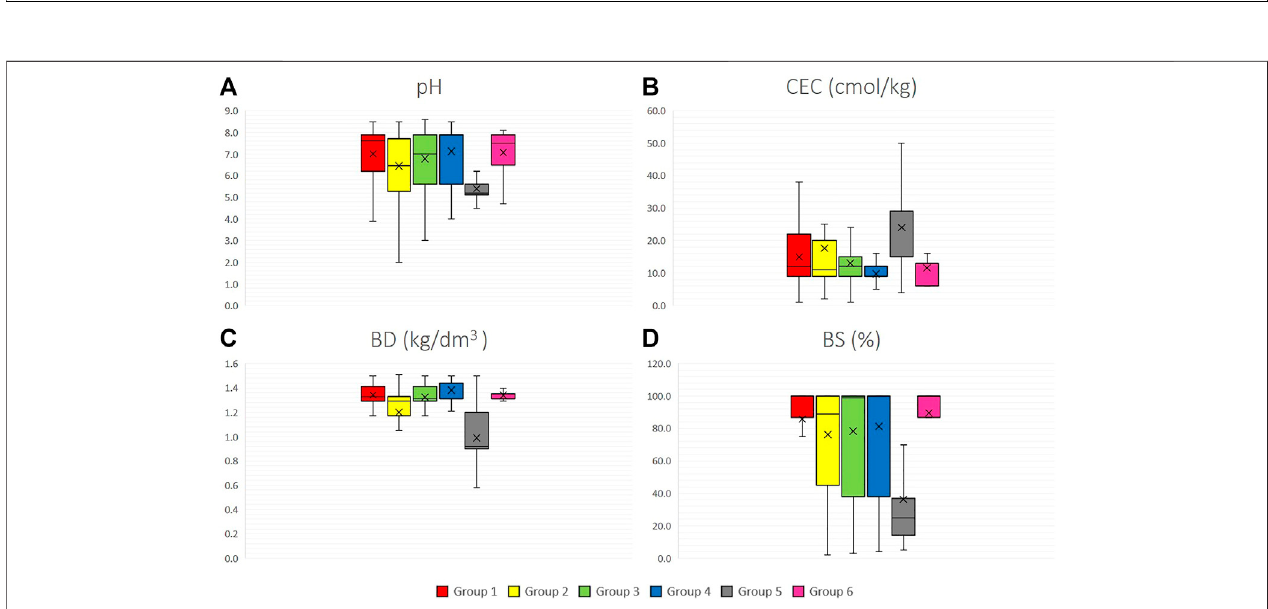
FIGURE5| Edaphicvariablesboxplotsforsixgroupsofthe12wildtomatospeciesand4relatedspecies (A) pH, (B) CEC(cationexchangecapacity), (C) BD(bulk density), (D) BS (base saturation). Group 1: Section Lycopersicon: “ Lycopersicon group ” ( S. pimpinellifolium, S. cheesmaniae and S. galapagense ), Group 2: “ Arcanum group ” ( S. arcanum , S. chmielewskii , and S. neorickii ), Group 3: “ Eriopersicon group ” ( S. habrochaites , S. huaylasense , S. corneliomulleri , S. peruvianum , and S. chilense ), Group 4: “ Neolycopersicon group ” ( S. pennellii ); outgroup close related species in Section Juglandifolia Group 5 ( S. juglandifolium and S. ochranthum ) and Group 6: Section Lycopersicoides ( S. lycopersicoides and S. sitiens